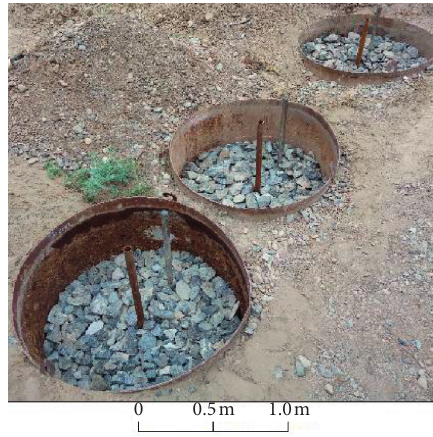
Figure 4: Backfilled waste rock at lower part of test barrels.